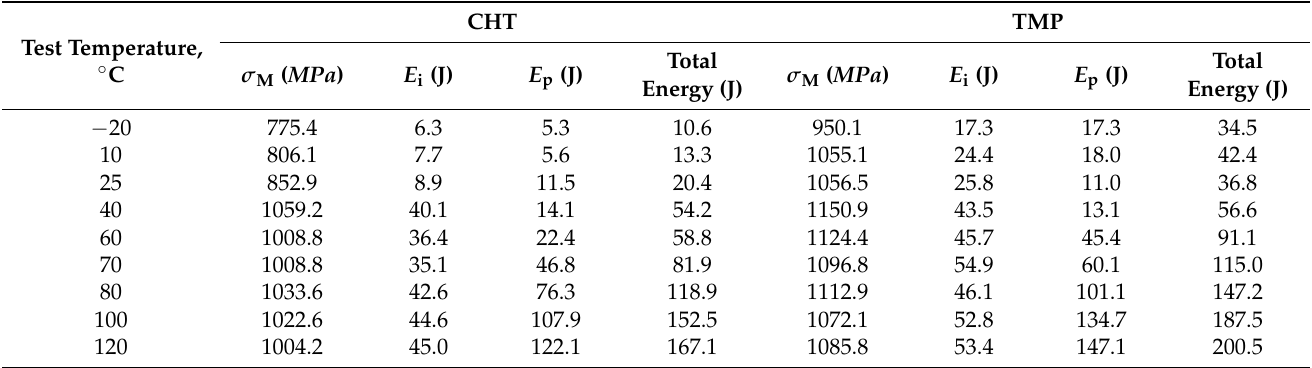
Table 4. Dynamic parameters calculated from the load vs. deflection